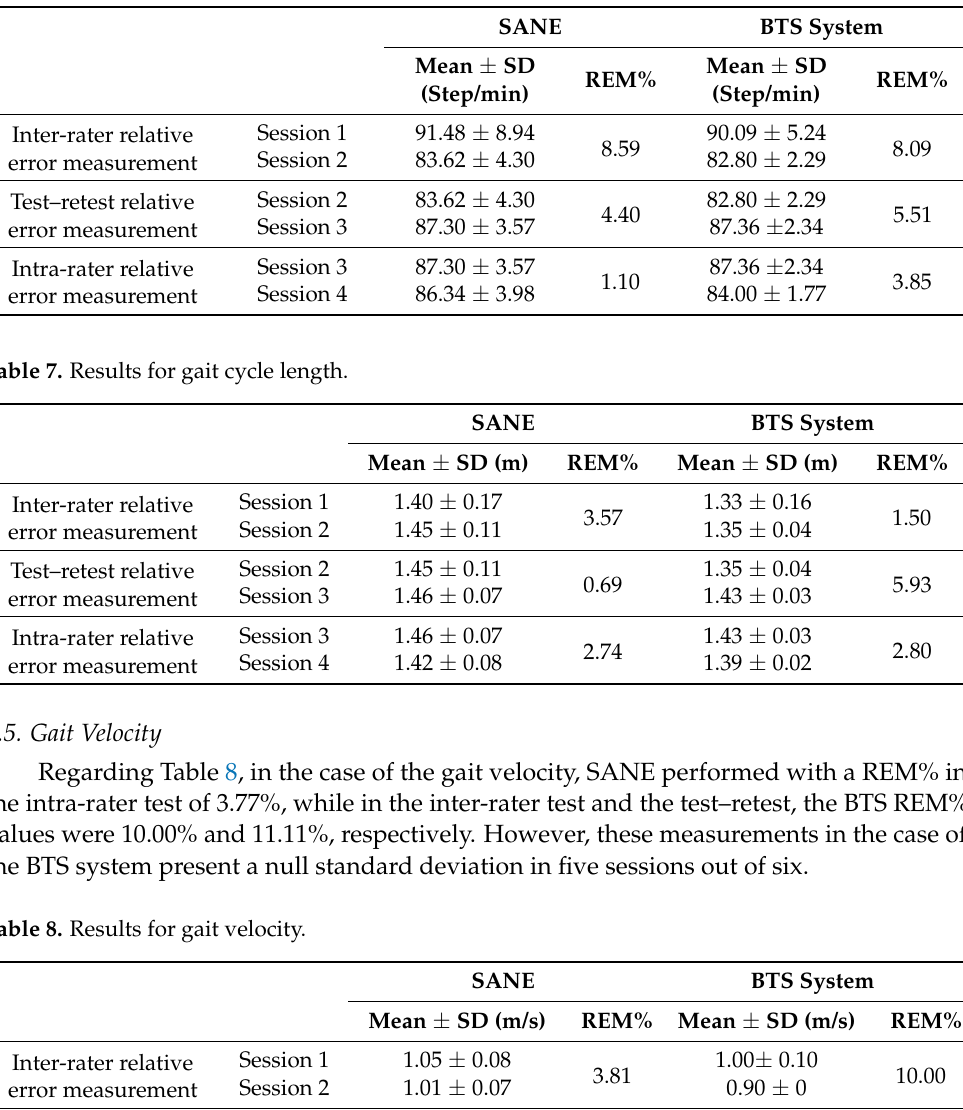
Table 6. Results for gait cadence.